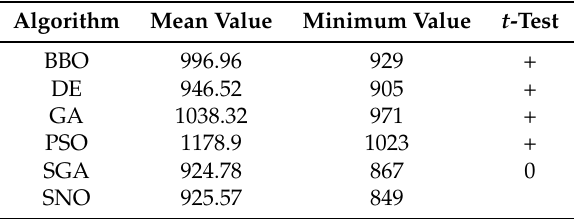
Table 3. Results of the algorithms.